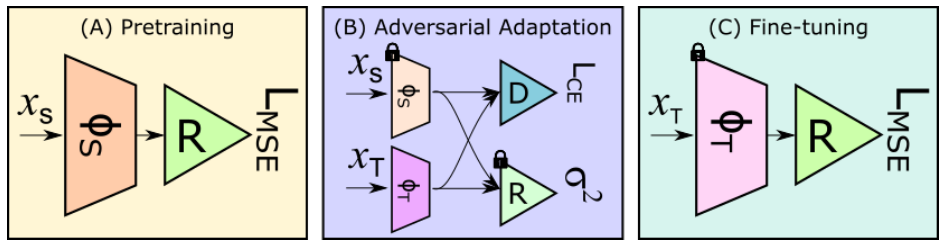
Figure 2. Overview of our training approach: φ S is the feature extractor for the source dataset ( φ T for the target dataset); R is the regressor network; D is the discriminator; L MSE indicates the mean square error loss function ( L CE is the cross-entropy loss); σ 2 is the variance-based regulariser preventing posterior collapse; locks indicate networks with fixed weights. The model obtained from the fine-tuning step is used for inference. (Best viewed in